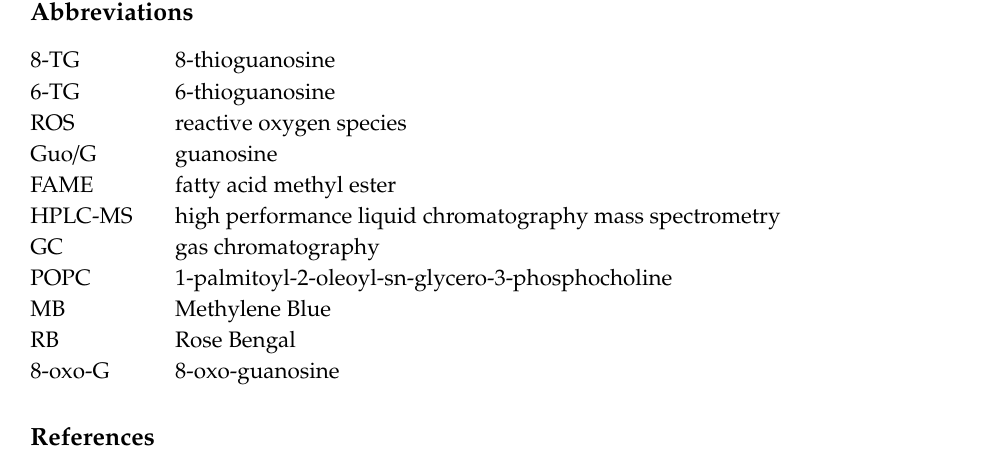
Figure S1: 1 H NMR spectrum of 8-TG; Figure S2: Zoomed 1 H NMR spectrum of 8-TG; Figure S3: 1 H NMR spectrum of 8-TG after adding D 2 O; Figure S4: Reaction of Br 2 •− with 8-TG; Figure S5: Reaction of N 3 • with 8-TG; Figure S6: Reaction of 8-TG in the presence of H 2 O 2 outside Gammacell; Figure S7: Reaction of HO • , H • , and e aq − with 8-TG in the presence of POPC liposomes; Figure S8: Reaction of e aq − with 8-TG in the presence of POPC liposomes; Figure S9: Reaction of HO • with 8-TG in the presence of POPC liposomes; Figure S10: Reaction of Br 2 •− with 8-TG in the presence of POPC liposomes; Figure S11: Reaction of N 3 • with 8-TG in the presence of POPC liposomes; Figure S12: Reaction of H 2 O 2 with 8-TG in the presence of POPC